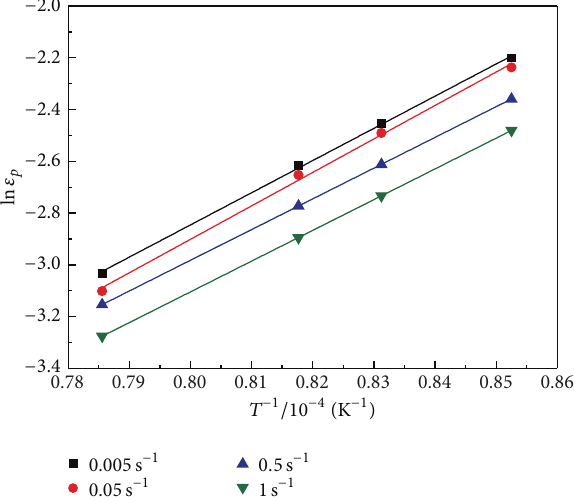
Figure 11: The relationships between ln 𝜀 𝑝 and 𝑇 −1 .